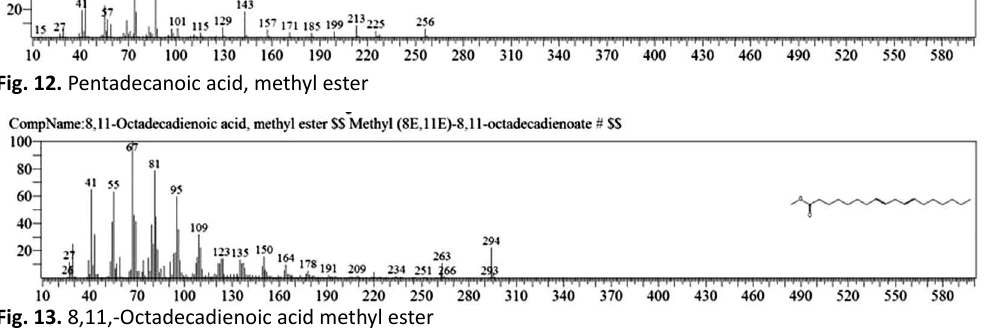
Fig. 13. 8,11,-Octadecadienoic acid methyl